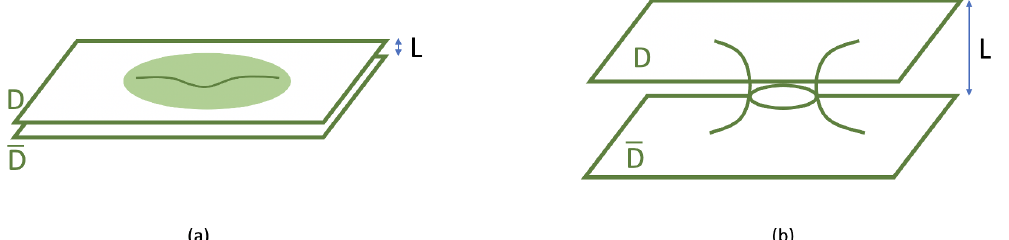
Figure 12 . We consider a brane and an anti-brane separated by a distance L . (a) When L − L c (cid:28) l s , we have an analogue of the Horowitz-Polchinski solution, where we have a condensate of open string mode and the two branes are deformed and get a bit closer in the middle. (b) When L (cid:29) l have a solution with the two branes are